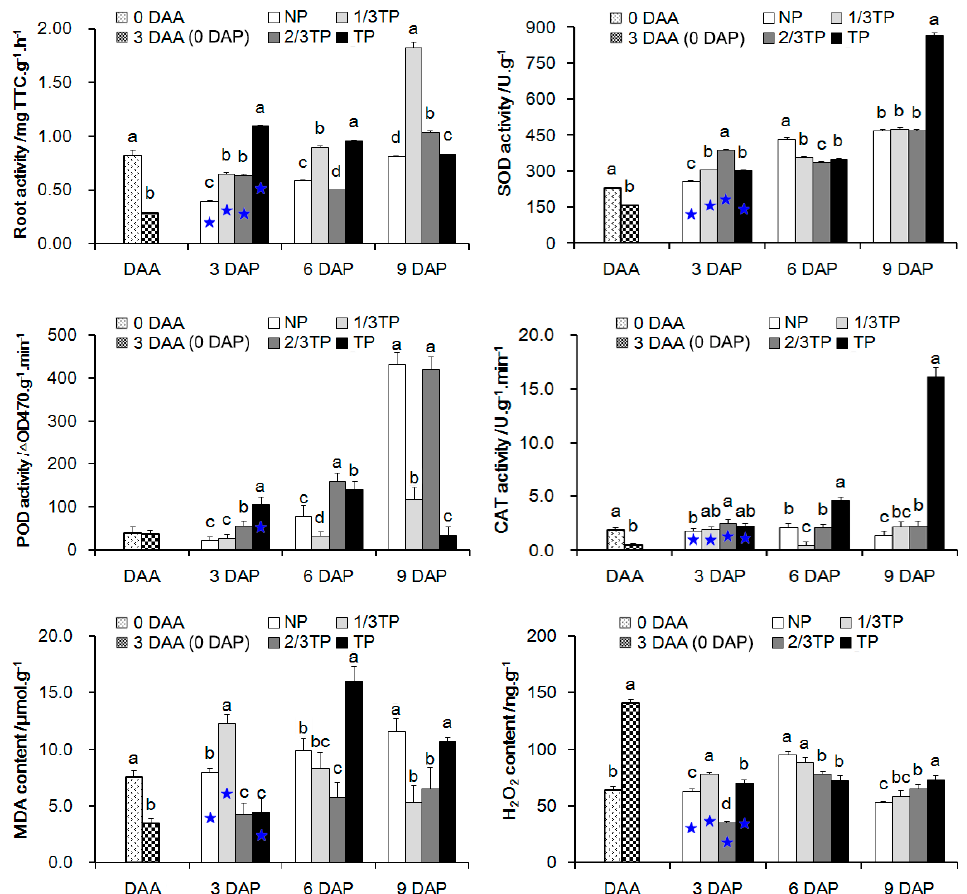
Figure 4. The contents of physiological indexes in R. glutinosa roots during acclimatization stage and planting stage with di ff erent replant disease stress levels. 0 DAA, 3 DAA (0 DAP), NP, 1 / 3TP, 2 / 3TP and TP are gradient treatments. Two or four samples in each group are compared with 3 DAA (0 DAP) and NP respectively, and di ff erent lower-case letters indicate significant di ff erences ( p < 0.05; LSD). 3 DAP with NP, 1 / 3TP, 2 / 3TP and TP gradient treatments is compared with 3 DAA (0 DAP), and the asterisk indicate significant di ff erences ( p < 0.05; LSD). Data represented as the mean ± SD ( n = 3). DAA: Days after acclimatization. DAP: Days after planting. NP: Soil that was never planted with R. glutinosa for